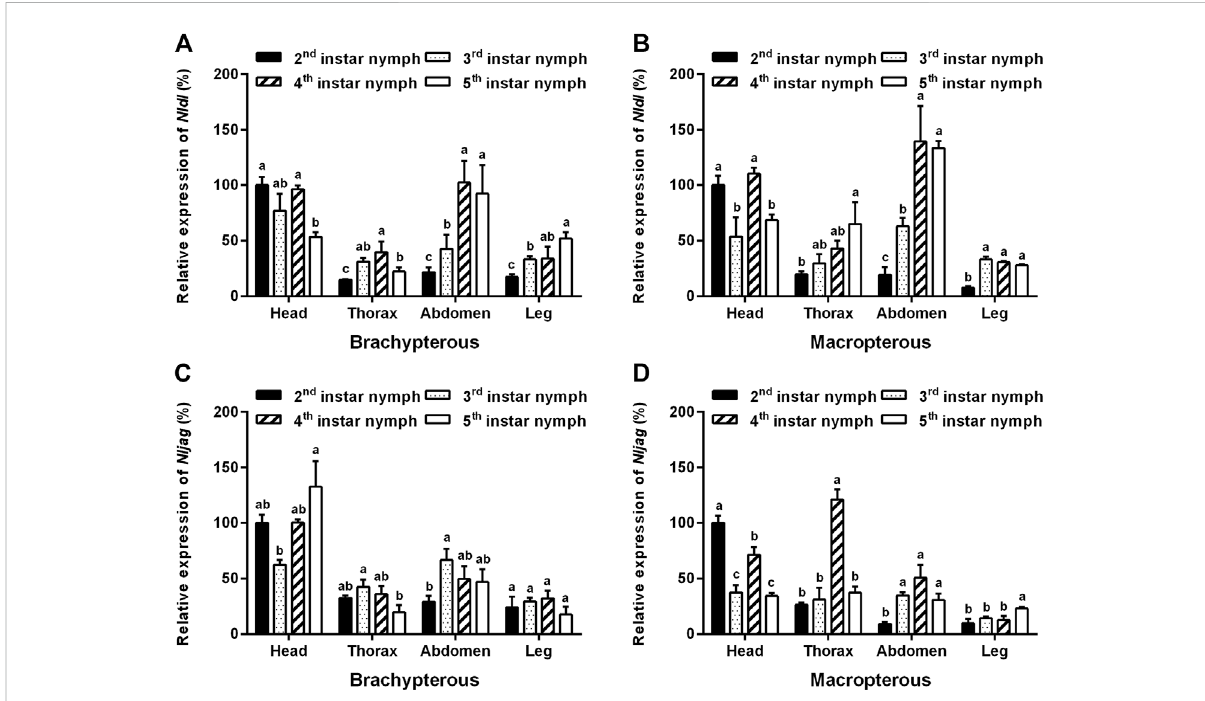
FIGURE 4 Spatiotemporal expression analysis of Nldelta and Nljagged in BPH nymphs by qPCR detection. (A) Expression pro fi le of Nldelta in the Brachypterous strain. (B) Expression pro fi le of Nldelta in the Macropterous strain. (C) Expression pro fi le of Nljagged in the Brachypterous strain. (D) Expression pro fi le of Nljagged in the Macropterous strain. Shown are the means ± standard error of three biological replicates, with 50 respective nymph tissues per replicate. Nlactin1 was used as a housekeeping gene for quantitation of relative expression levels of the test genes. Data represent the mean ± standard error ( n = 3). The expression level of the test gene in the head of the second-instar nymph was de fi ned as 100%. Different letters on the top of the columns indicate signi fi cant differences in expression levels between instars in the same tissue, as assessed using Tukey ’ s test ( p <